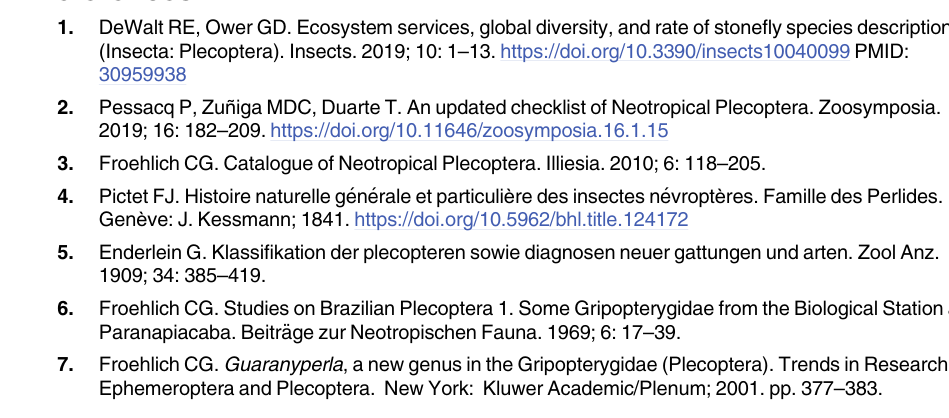
S2 Fig. Brazilian states. Brazilian states with their respective acronyms and full